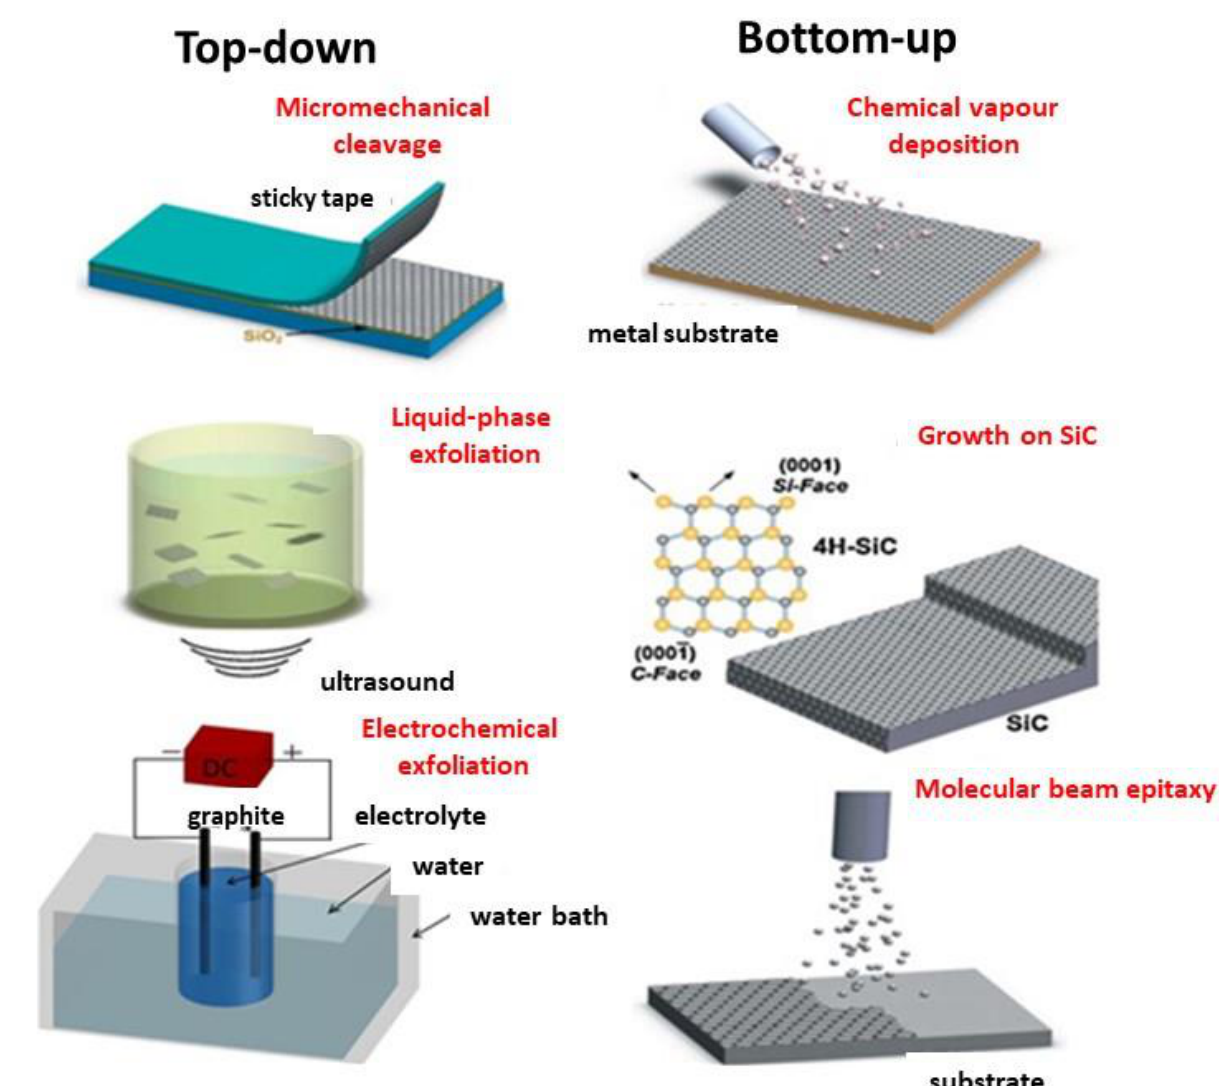
Figure 4. Top–down and bottom–up approaches for graphene Figure 4. Top – down and bottom – up approaches for graphene manufacture.